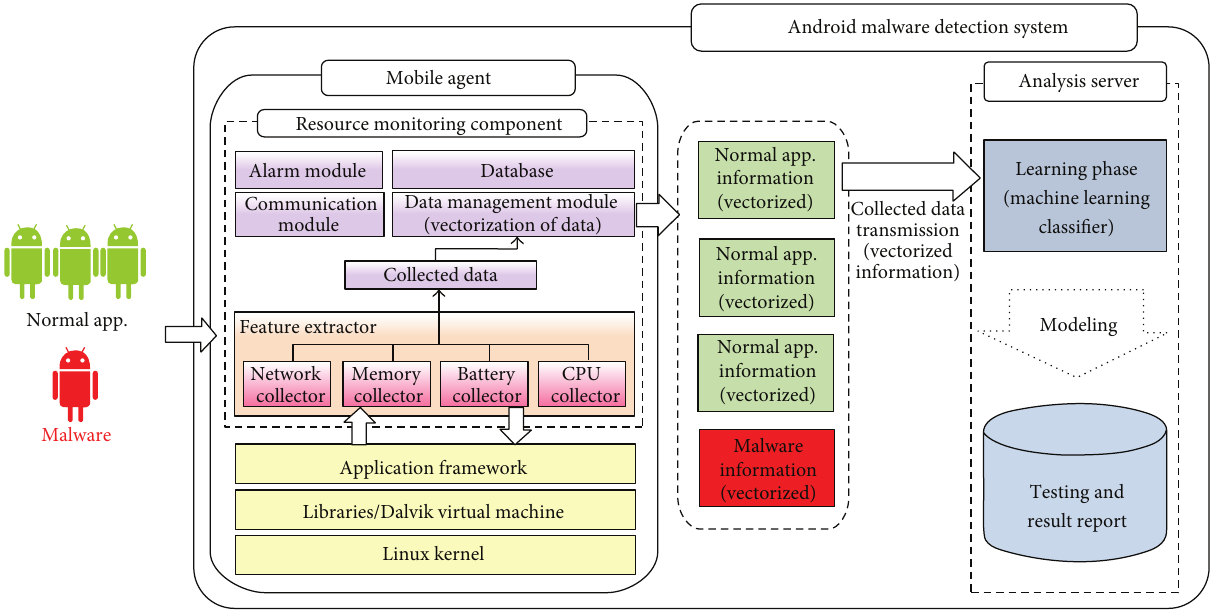
Figure 3: Android malware detection system